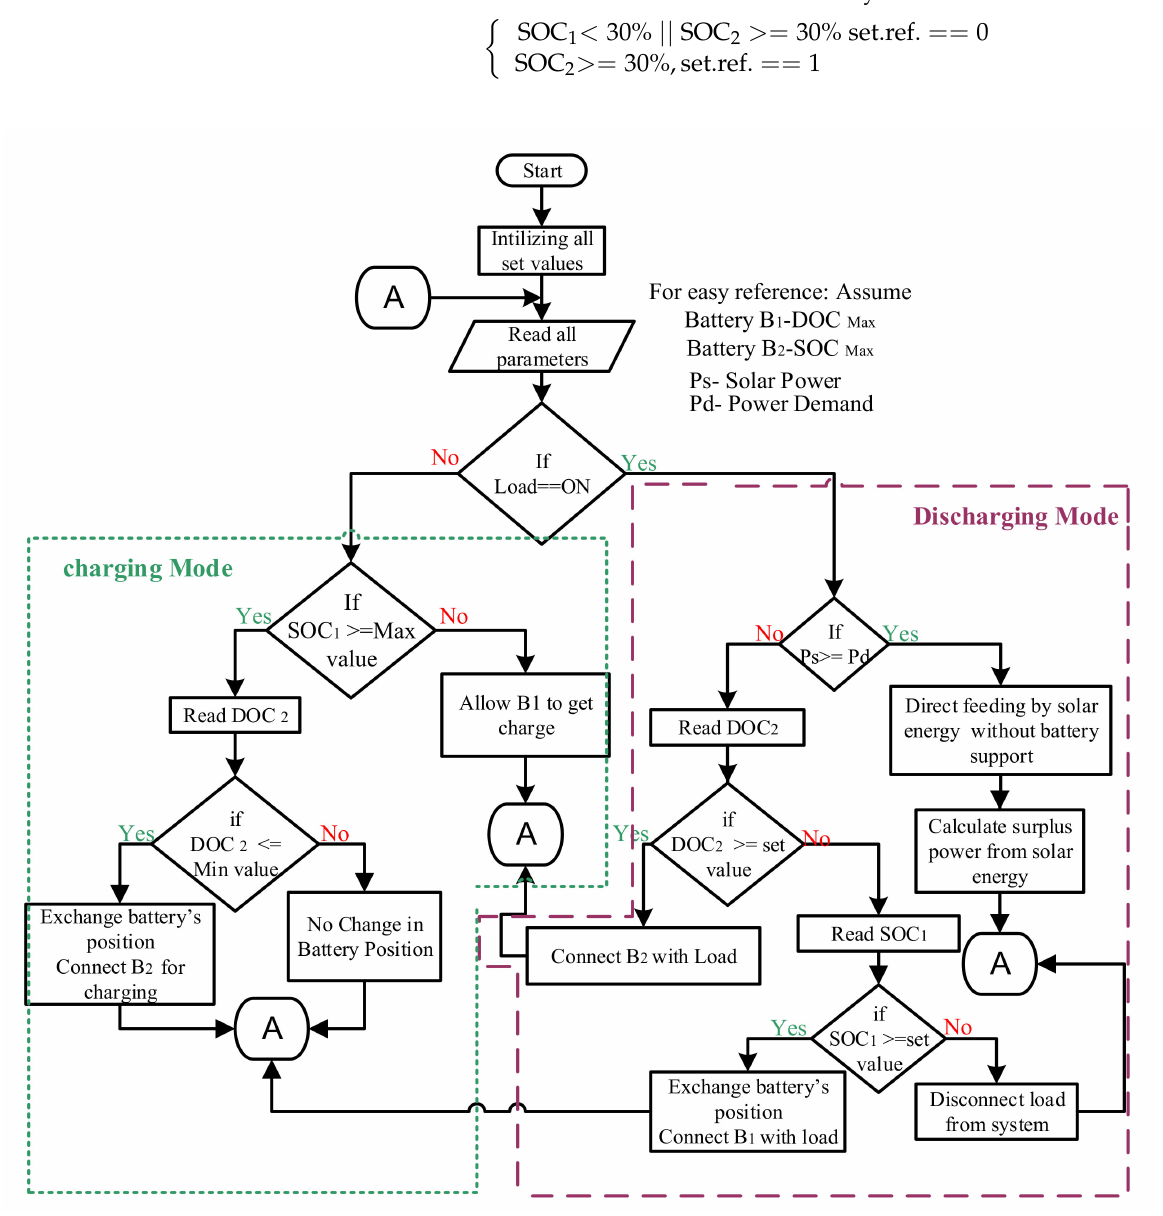
Figure 3. Flowchart of the dual battery storage